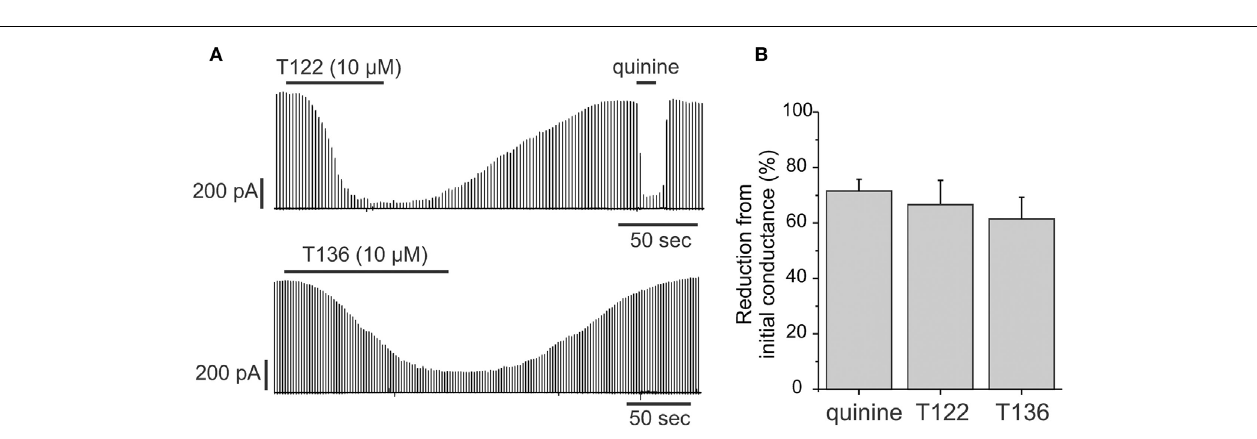
FIGURE 8 |T122 andT136 reduce junctional conductance in lens epithelial cells. (A) Effect of 10 μ MT122 (top) and 10 μ MT136 (bottom) on junctional currents in epithelial cells isolated from P6 lenses.The magnitude of inhibition is similar to that produced by quinine.The